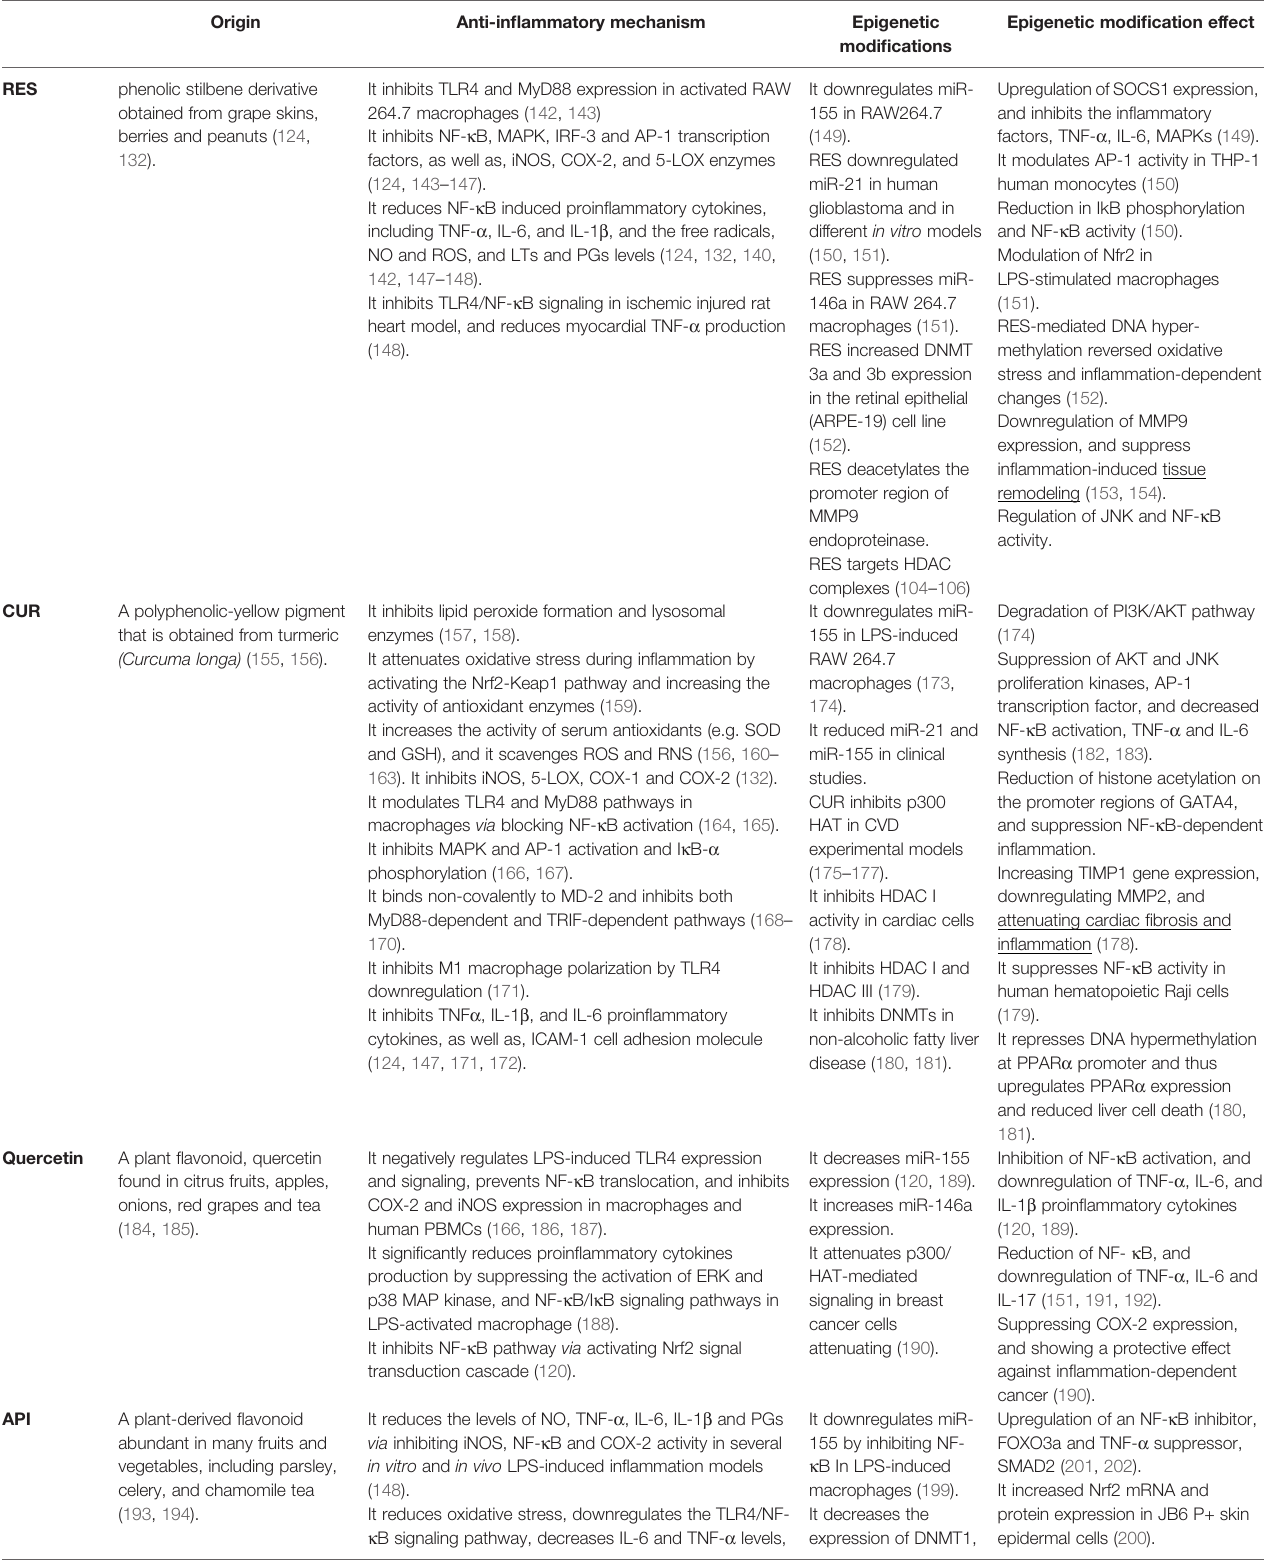
TABLE 1 | The anti-in fl ammatory mechanism(s) of phytochemicals and their associated epigenetic modi fi cations/effect.